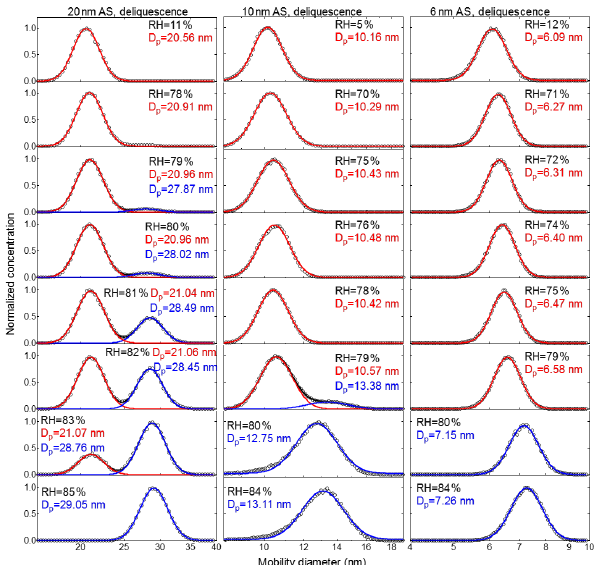
Figure 5. Deliquescence-mode measurements of ammonium sulfate (AS) aerosol nanoparticles with a dry mobility diameter from 20– 6nm. The measured (black circles) and fitted (solid lines) normal- ized size distribution are shown for increasing RH. The red and blue lines represent the aerosol nanoparticles in the solid and liquid state, respectively. The RH history in each measurement is 5% → X %, where X is the RH value given in each